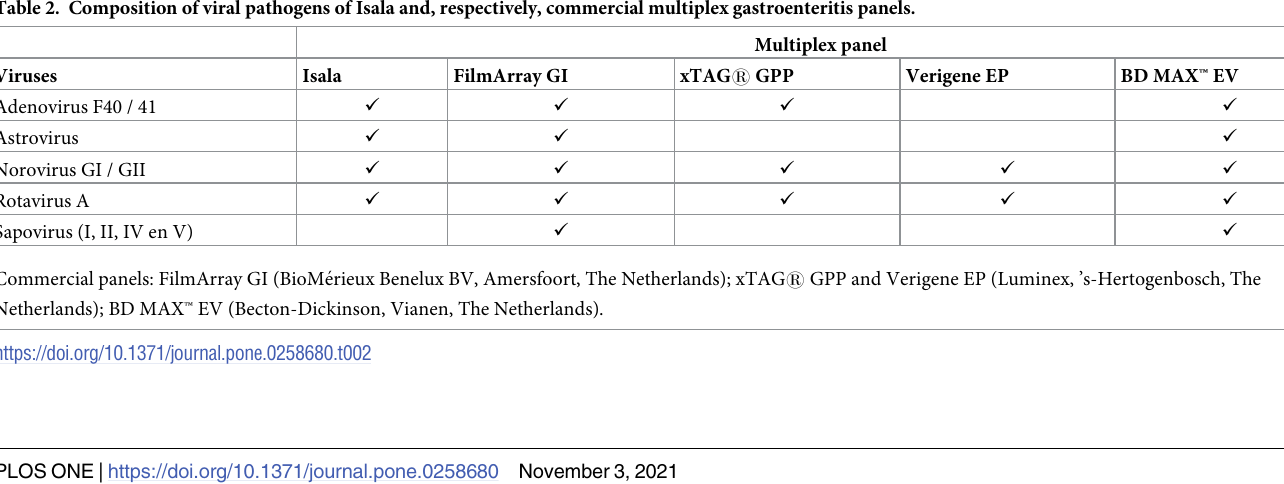
Table 2. Composition of viral pathogens of Isala and, respectively, commercial multiplex gastroenteritis panels.